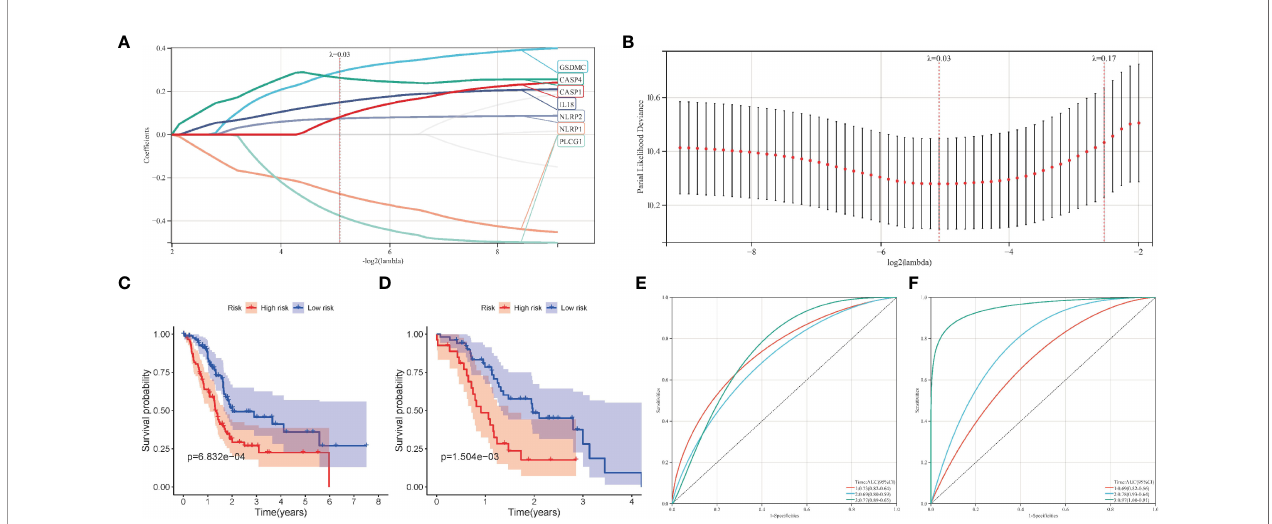
FIGURE 4 | Construction of the pyroptosis-related prognostic model in pancreatic cancer. (A, B) The lasso-penalized Cox regression analysis for pyroptosis-related genes in TCGA cohort. (C, D) Kaplan-Meier survival analysis of high-risk and low-risk group in TCGA and ICGC cohort. (E, F) Receiver operating characteristic (ROC) curves for 1, 2, and 3 years survival in TCGA and ICGC cohort.